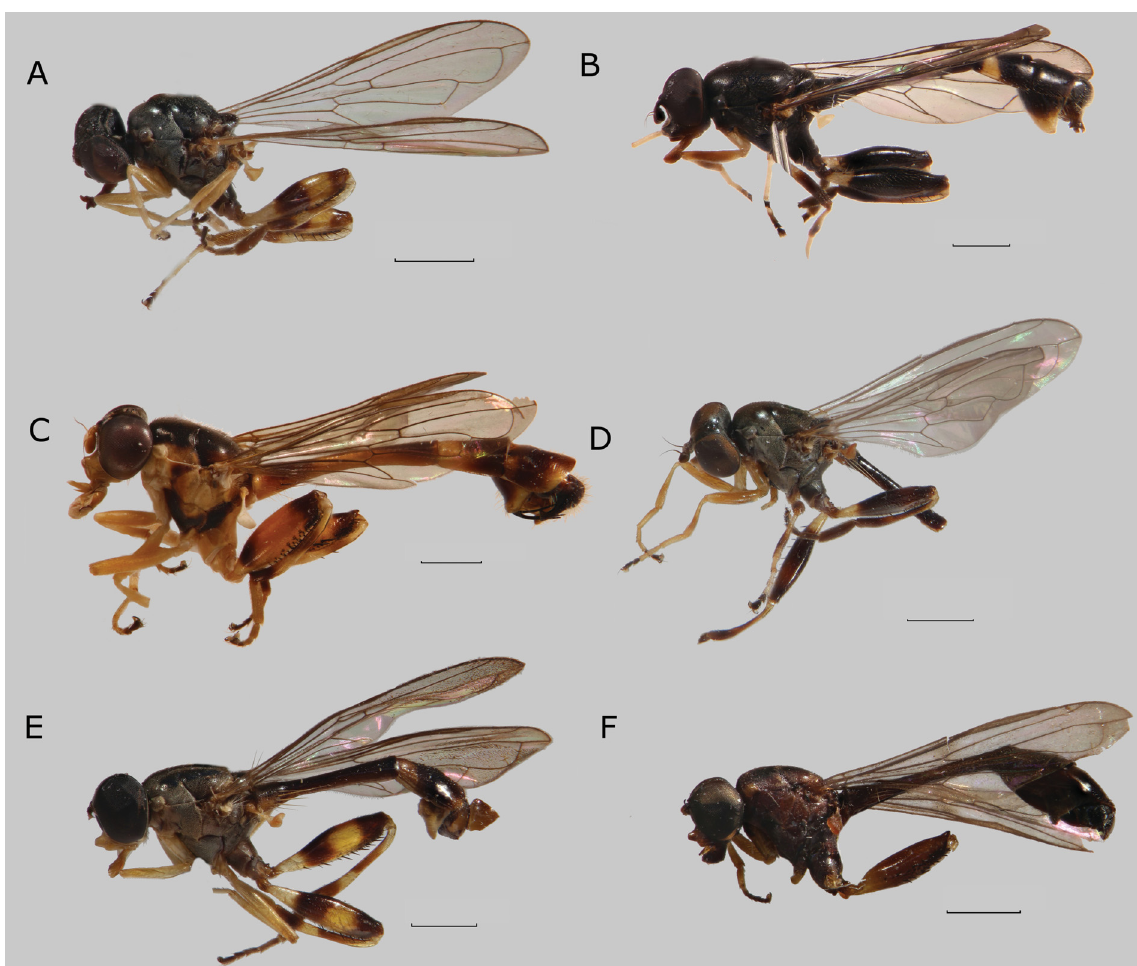
Fig. 28. Habitus, lateral view. A . Sphegina (Asiosphegina) cultrigera Hippa, van Steenis & Mu tin, 2015, paratype, ♂ , Myanmar. B . S. (A.) dentata sp. nov., paratype, ♂ , Taiwan. C . S. (A.) distincta sp. nov., paratype, ♂ , Vietnam. D . S. (A.) exilipes sp. nov., holotype, ♂ , Java, Indonesia. E . S. ( A.) farinosa sp. nov., holotype, ♂ , Sabah, Malaysia. F . S. ( A.) fi mbriata sp. nov., holotype, ♂ , Thailand. Scale bars = 1.0